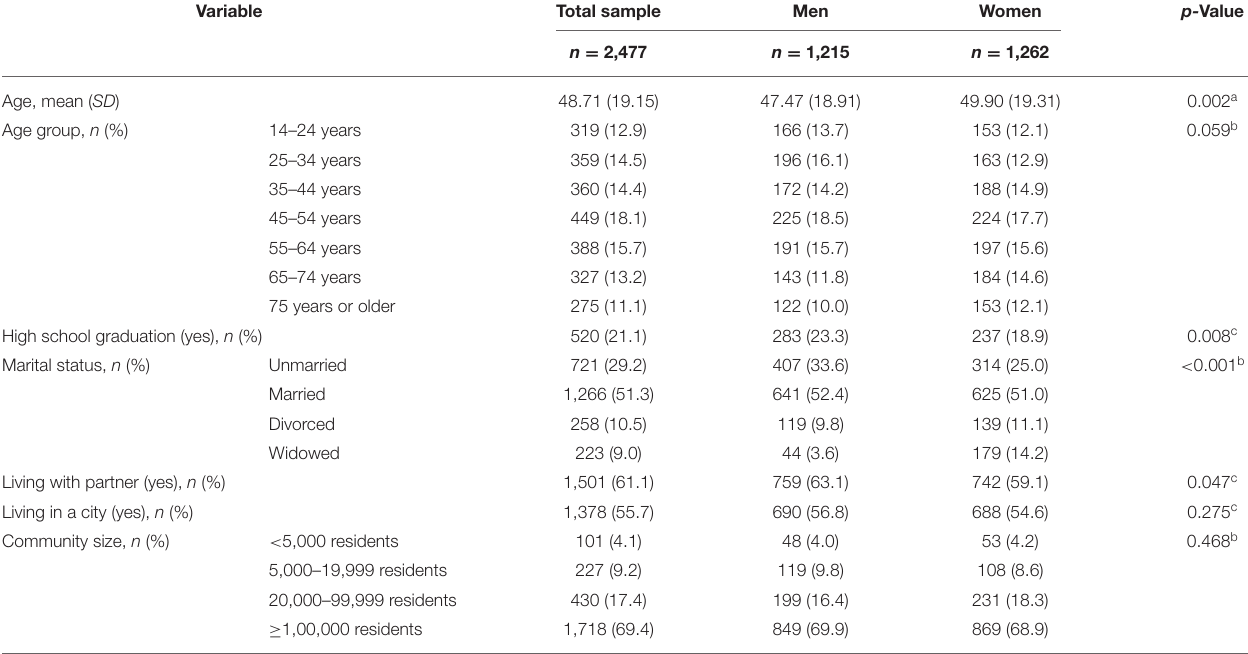
TABLE 1 | Sociodemographic characteristics of the study sample according to sex.